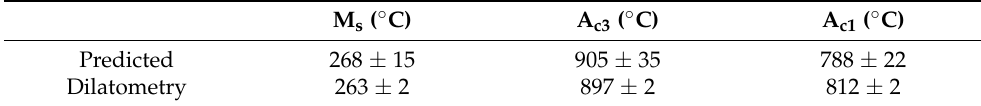
Table 2. Determination of M s , A c1, and A c3